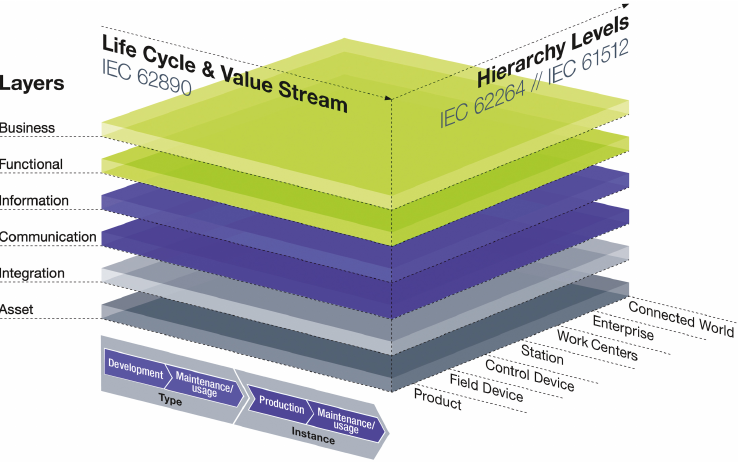
Figure 3. RAMI 4.0. Reference service-oriented architecture for Industry 4.0